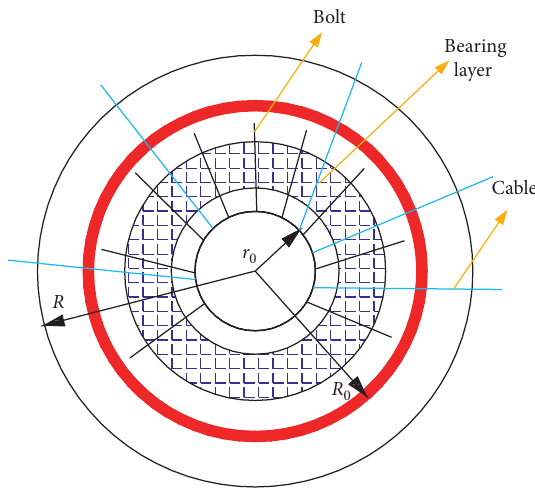
Figure 12: Relationship between loose ring and support position.